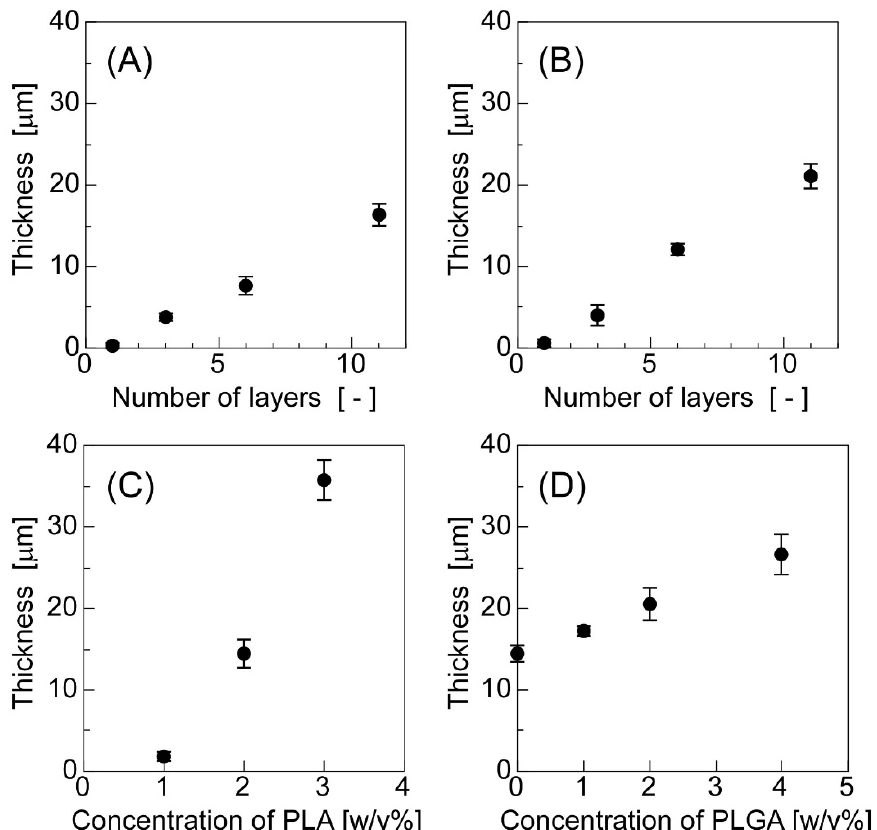
Figure 3. The effects of the number of layers and polymer concentrations on the thickness of the sheets: ( A ) sheets prepared with a PLA (2 w/v%) solution, ( B ) sheets prepared with a PLA (2 w/v%) + PLGA (2 w/v%) solution, ( C ) sheets prepared with a PLA solution (number of layers: 11), and ( D ) sheets prepared with a PLA (2 w/v%) + PLGA solution (number of layers: 11). The polymer concentrations indicate the values at the preparation stage of the emulsions.